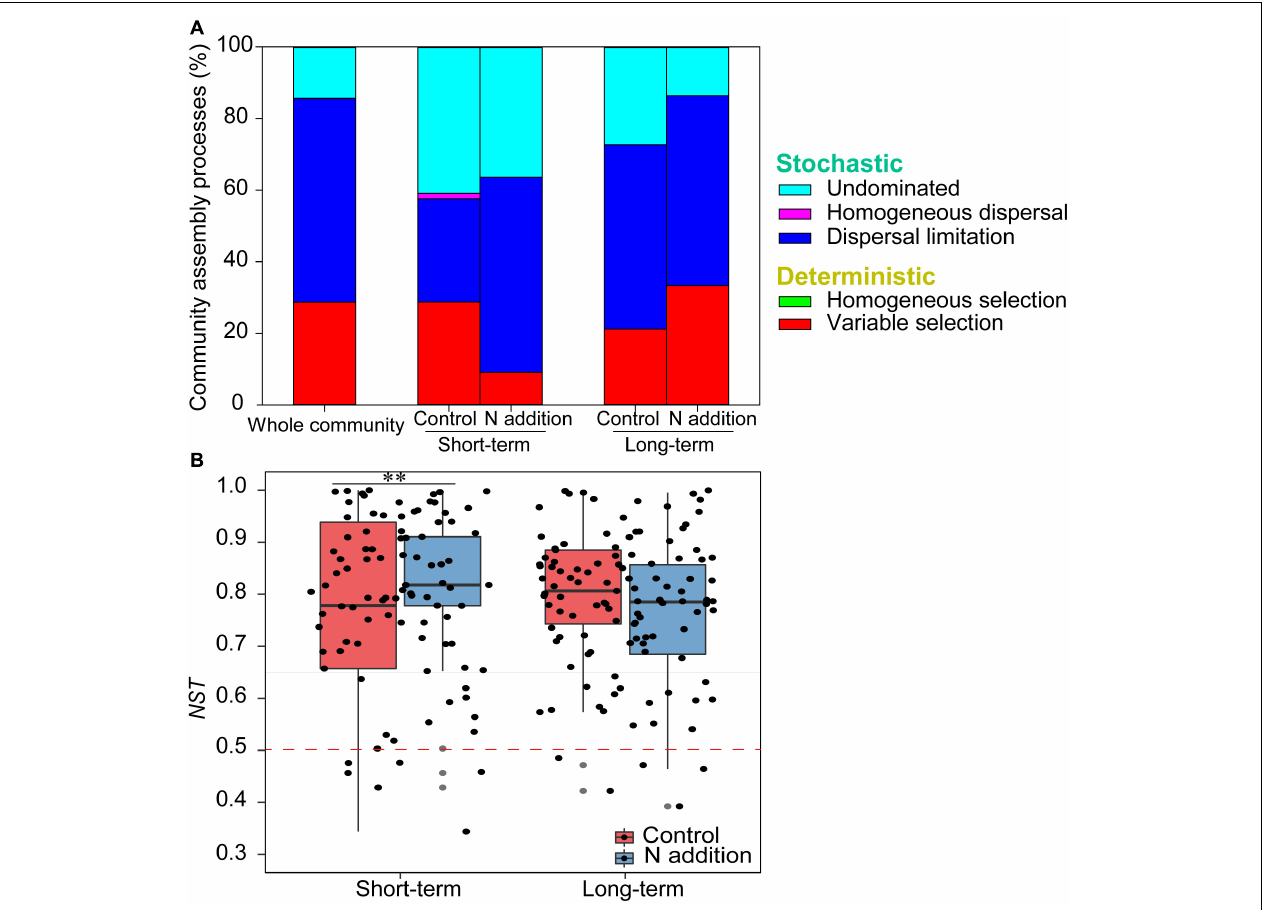
FIGURE 5 | The assembly processes in shaping fungal community. (A) The relative contributions (%) of the five community assembly processes. (B) Boxplot shows the variation in NST under control and N addition at the short- and long-term sites ( ∗∗ p < 0.01; Wilcoxon rank-sum